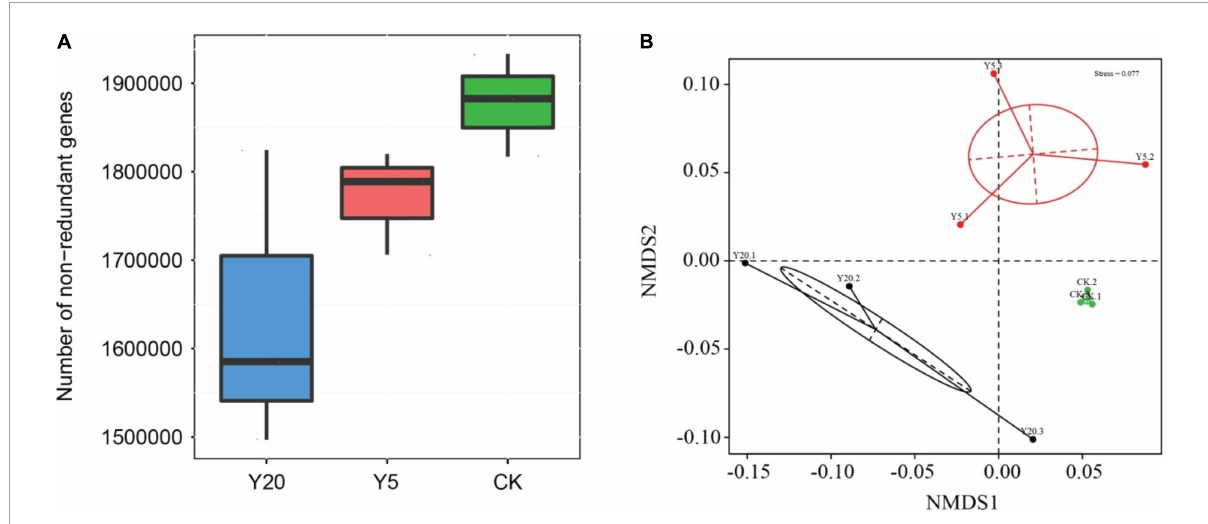
FIGURE1 (A) A box plot showing non-redundant genes in M. integrifolia group samples ( CK = 1-year monoculture orchard, Y5 = 5-year monoculture orchard, and Y20 = 20-year monoculture orchard). Boxes represent the interquartile ranges and lines represent the median values. (B) Non-metric multi-dimensional scaling (NDMS) analysis of all three treatments and their replicates (1-year monoculture orchard = CK.1 , CK.2 , and CK.3 ; 5-year monoculture orchard = Y5.1 , Y5.2 , and Y5.3 ; and 20-year monoculture orchard = Y20.1 , Y20.2 , and Y20.3 ). Each point represents different samples, and the distance between points indicates the degree of difference.